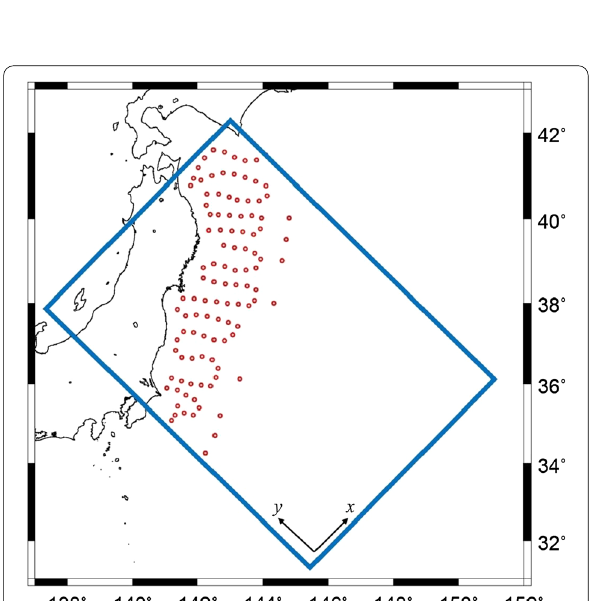
Fig. 1 Location of ocean bottom pressure sensors in S-net (red circle) used in this study. The blue rectangle denotes the air–sea coupled tsunami computation